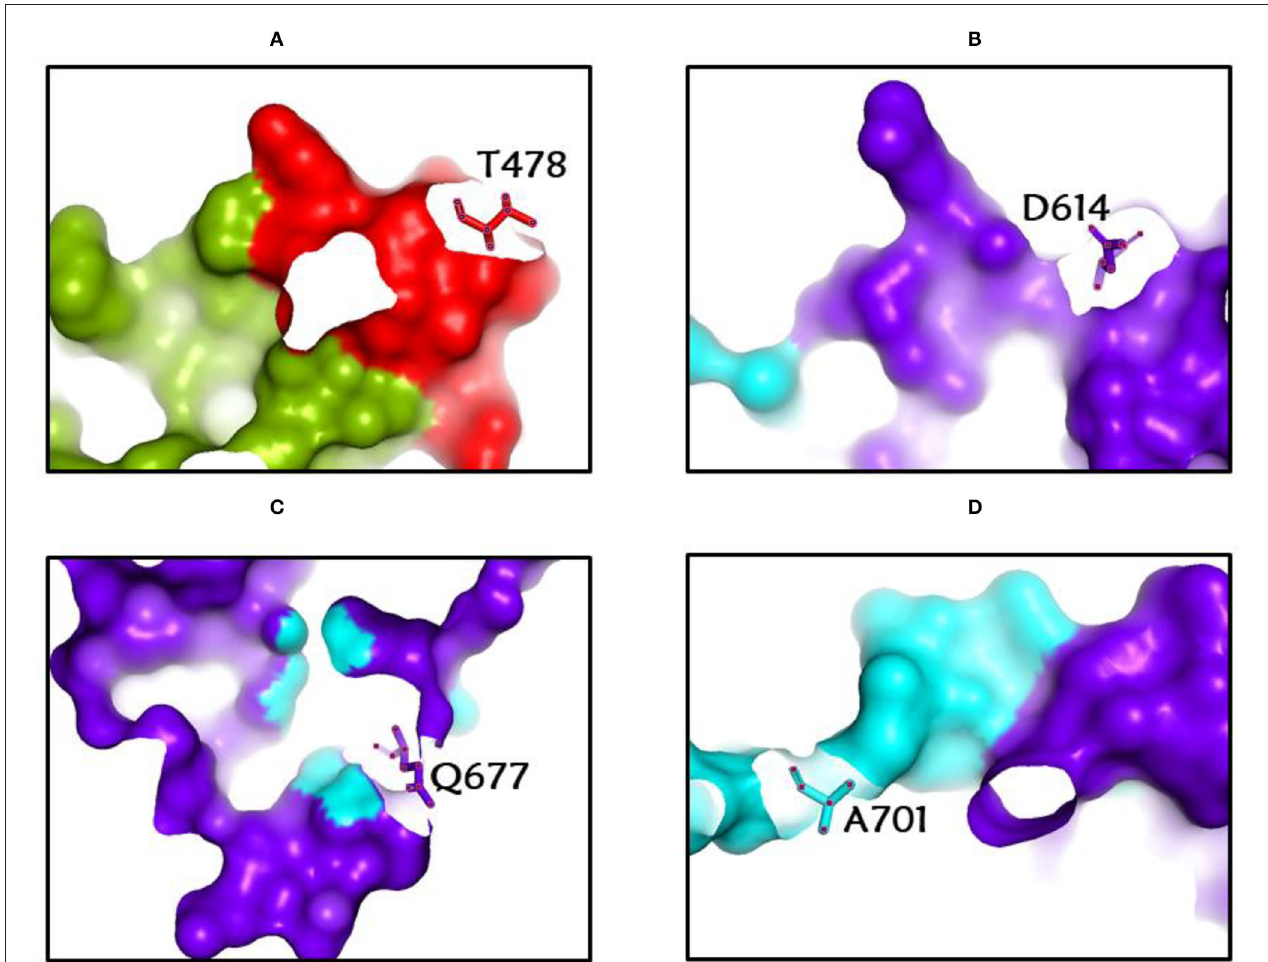
FIGURE 3 | (A-D) The most common spike glycoprotein residues (T478, D614, Q677, A701) where diverse mutations occur, resulting in different SARS-CoV-2 VOCs, VOIs, and VBMs.